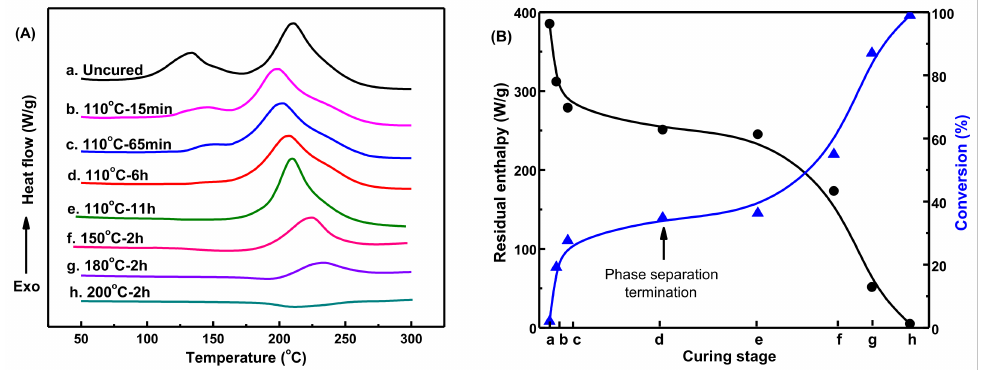
Figure 6. ( A ) DSC curves, ( B ) the Residual enthalpy and corresponding conversion of MOEA- BOZ/DGEBA-ER/IMZ (12 wt%) blend with 30 wt% of ER after curing at different